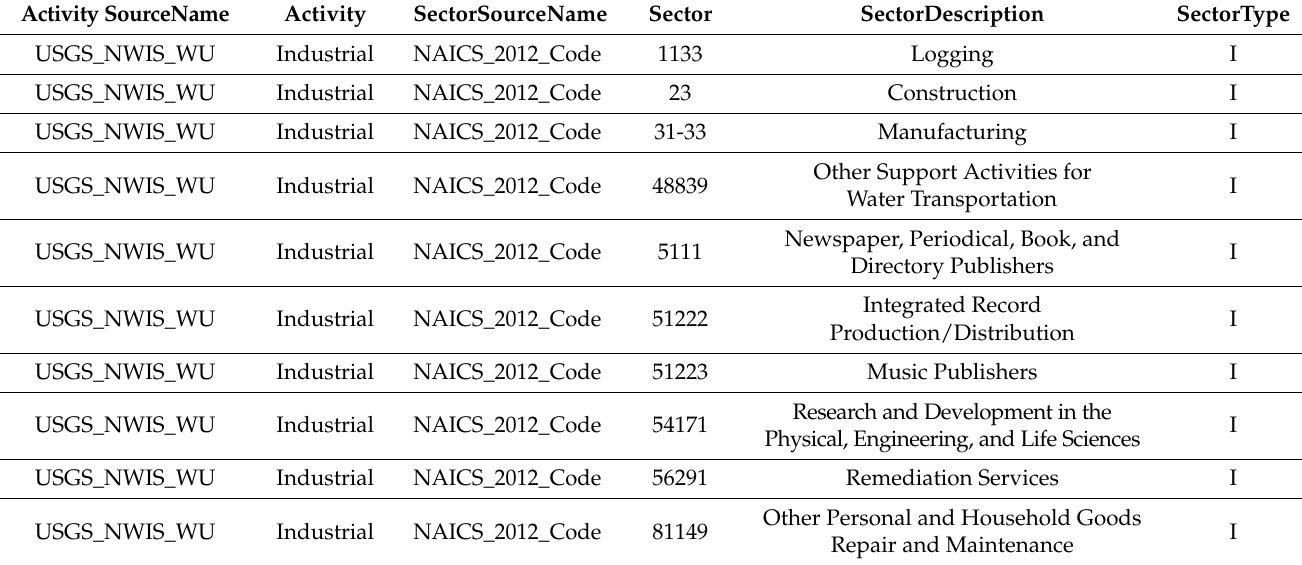
Table 3. Activity-to-Sector Mapping for USGS_NWIS_WU